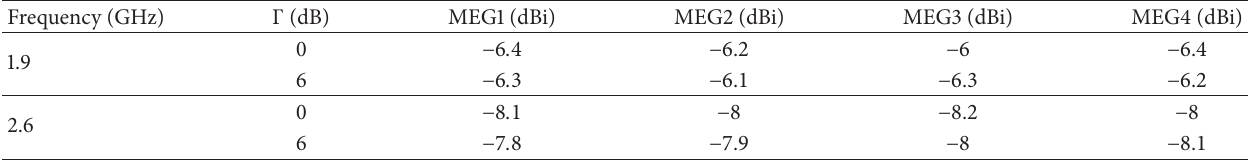
Table 1: Mean effective gains of the antennas.